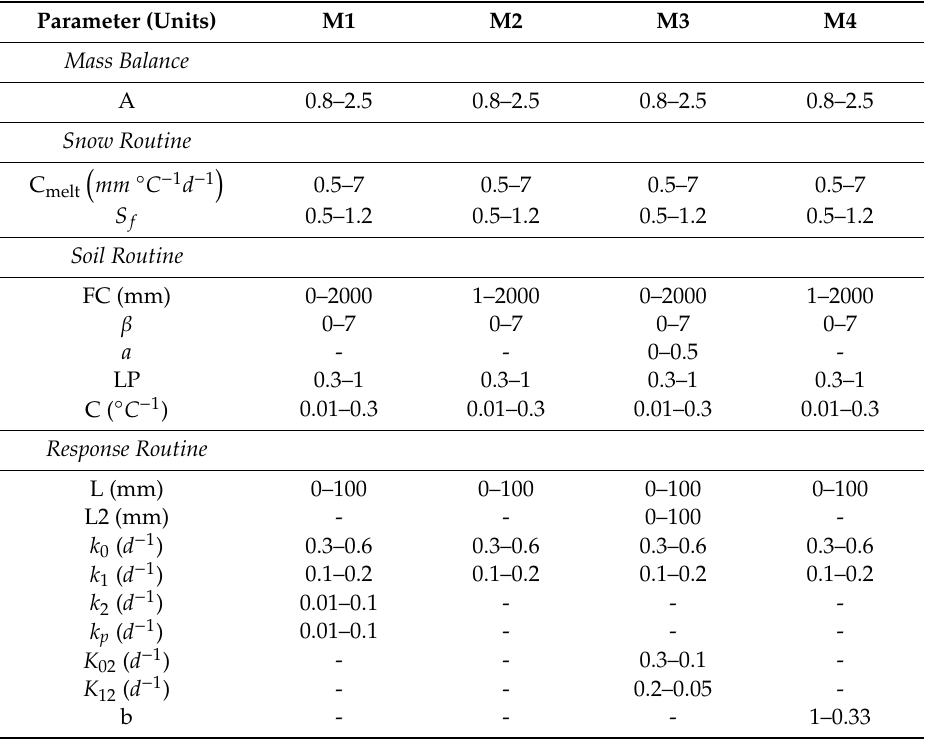
Table 2. Calibration parameter ranges for each